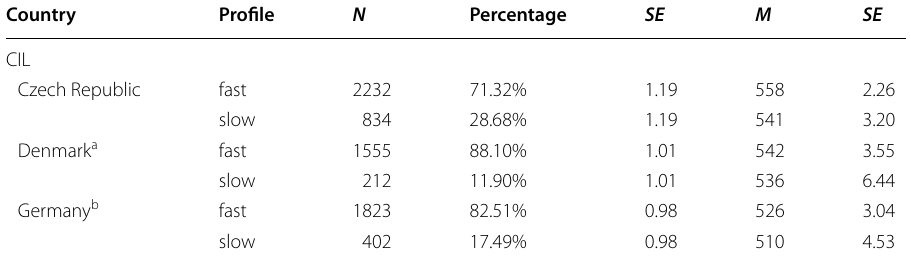
a Did not meet sample requirements b